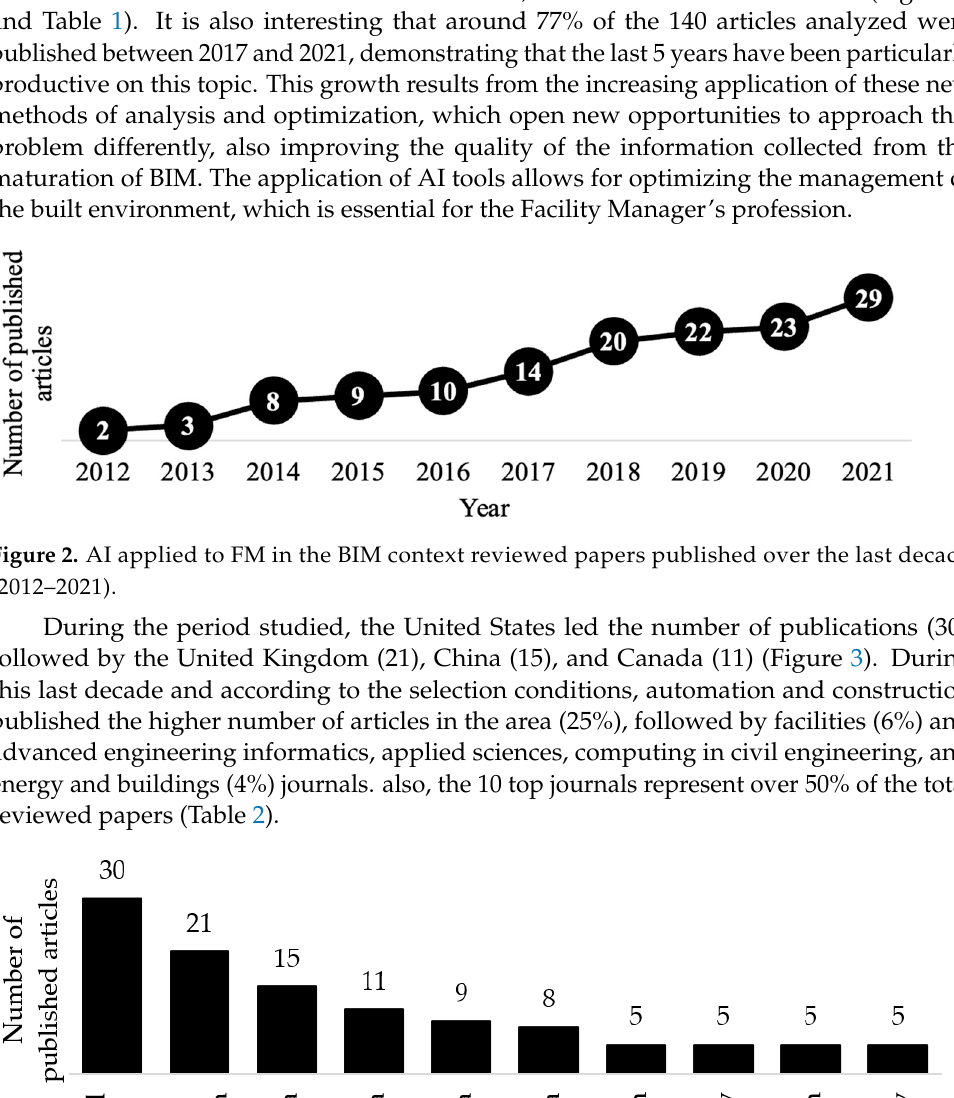
Figure 3. AI applied to FM papers published over the last decade and countries or territories (2012– 2021).